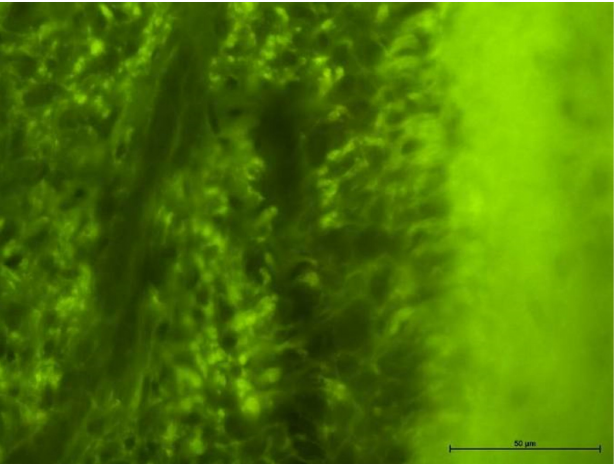
Figure 7. Fluorescence microscope image, human molar—Group III. Visible angiogenesis (arrow) in the dentin region (Z). UV-2A. Mag. 200 ×